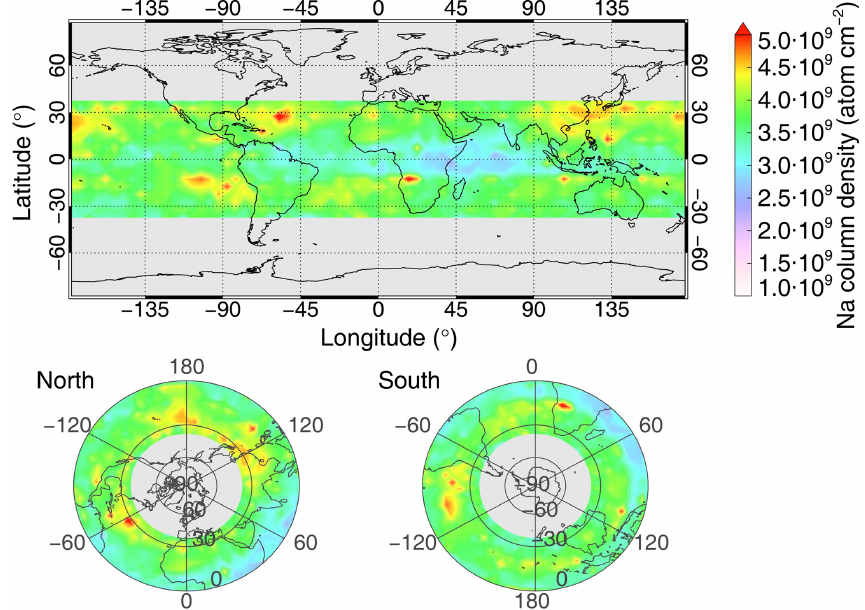
Figure 4. Geographical distribution of the annual mean Na column number density below 40 ◦ latitude from the OSIRIS limb-scanning radiance measurements made by the Odin satellite during the period 2004 to 2009, with a spatial resolution of a 5 ◦ × 5 ◦ grid. Grey shading indicates the regions where there are no measurements or not enough measurements at mid- and high-latitudes in winter to calculate the annual